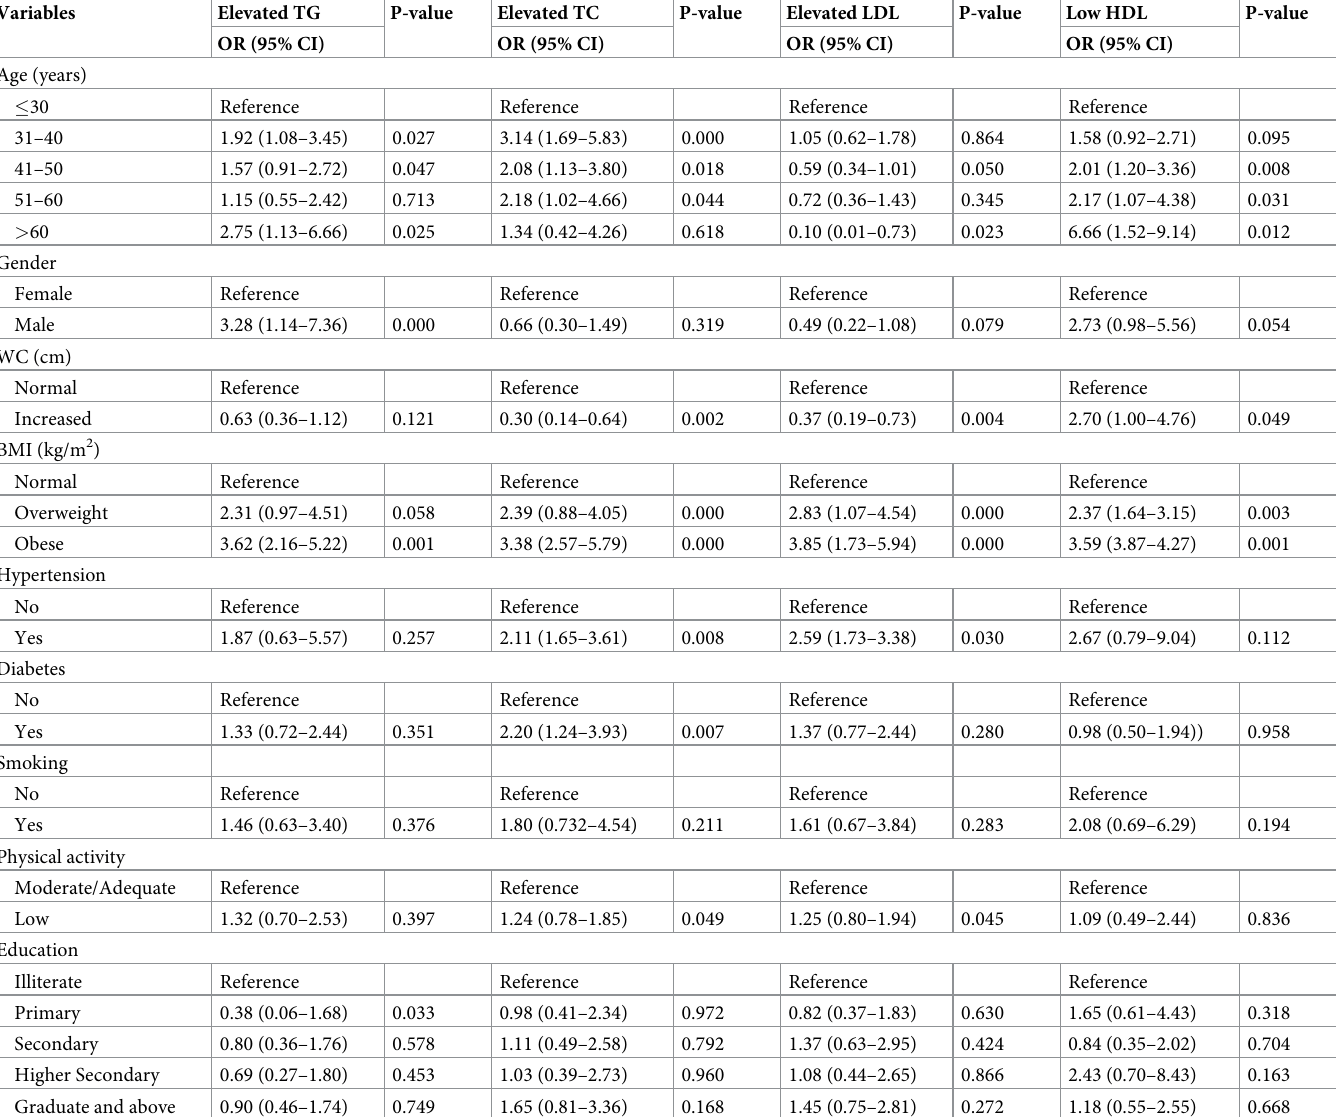
Table 5. Multivariable logistic regression for assessing factors independently associated with